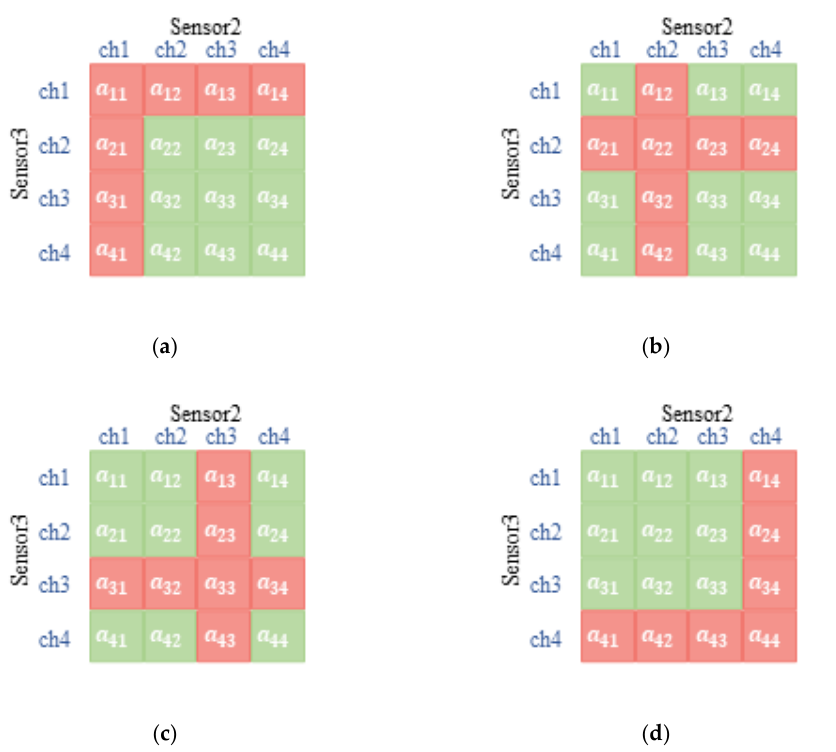
Figure 4. The diagram of the cubic relationship among sensors in sensor 1 ′ s version. ( a ) Sensor 1 chooses channel 1; ( b ) sensor 1 chooses channel 2; ( c ) sensor 1 chooses channel 3; ( d ) sensor 1 chooses channel 4.